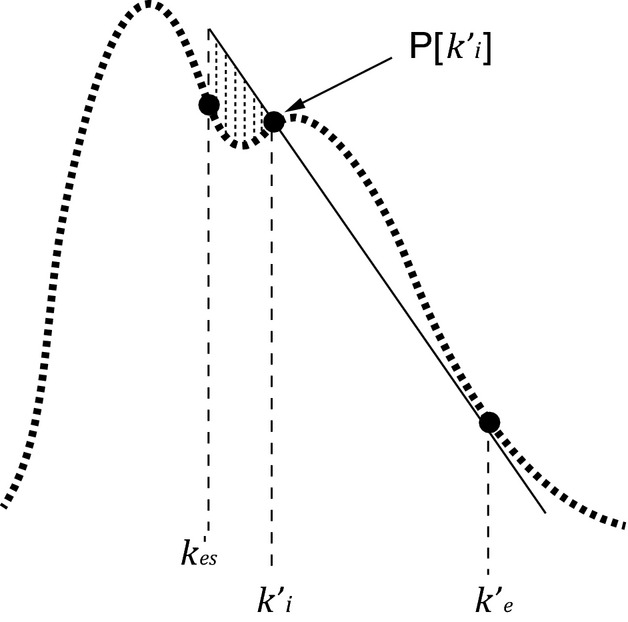
Landmarks for iterative evaluation of onset and end of diastolic wave.